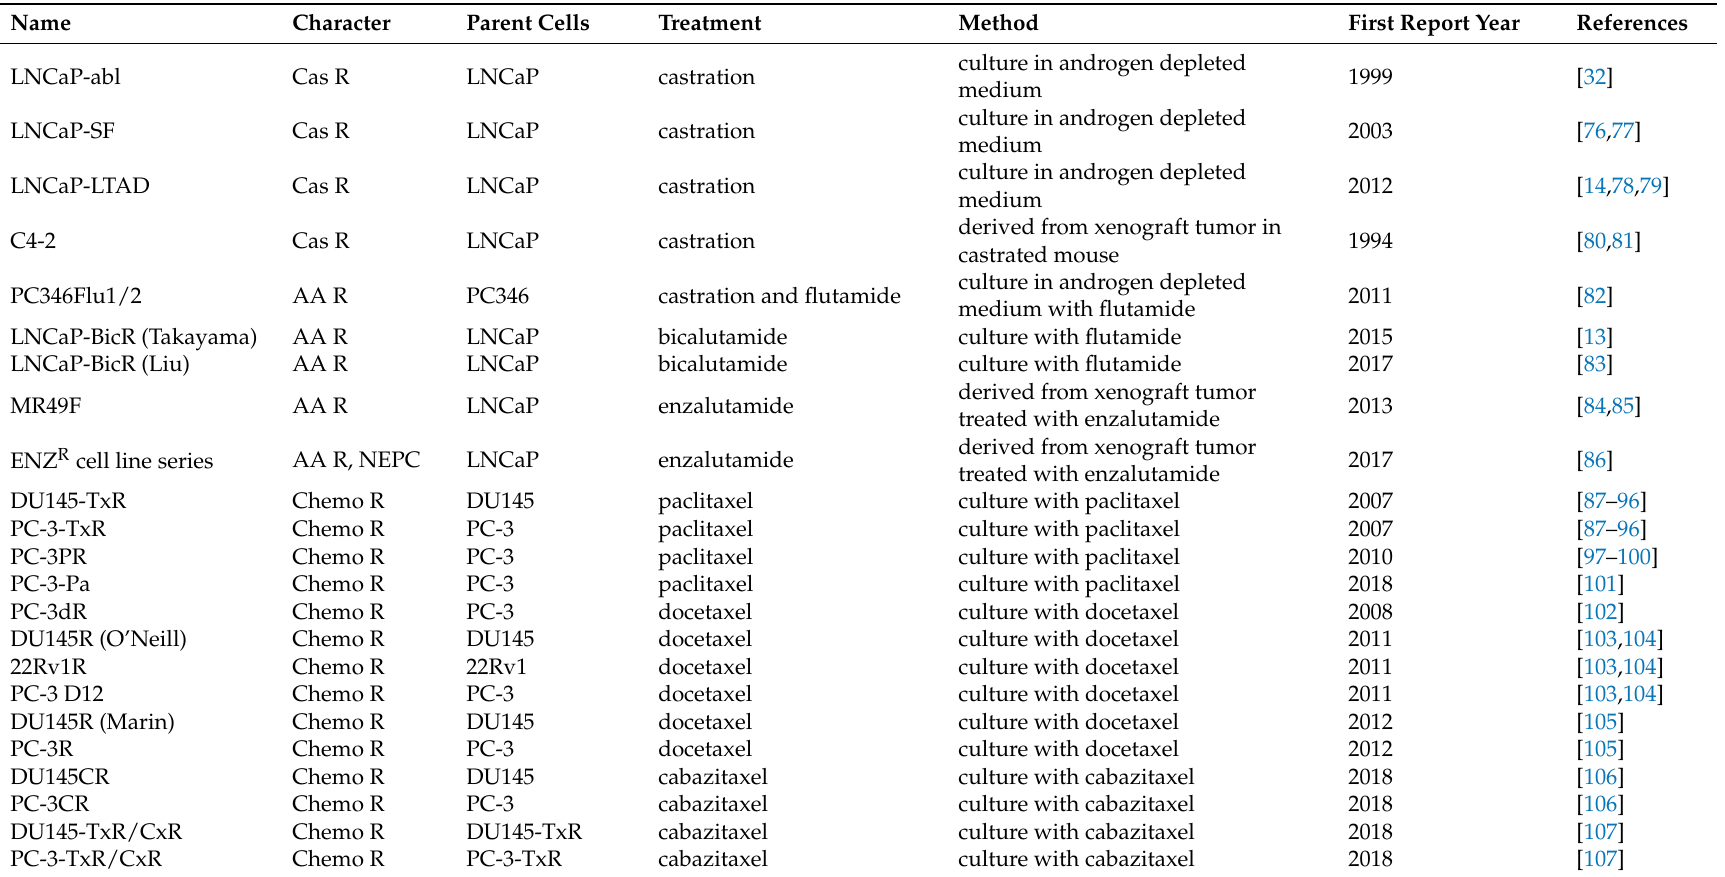
Table 2. Treatment-resistant sublines derived from prostate cancer cell